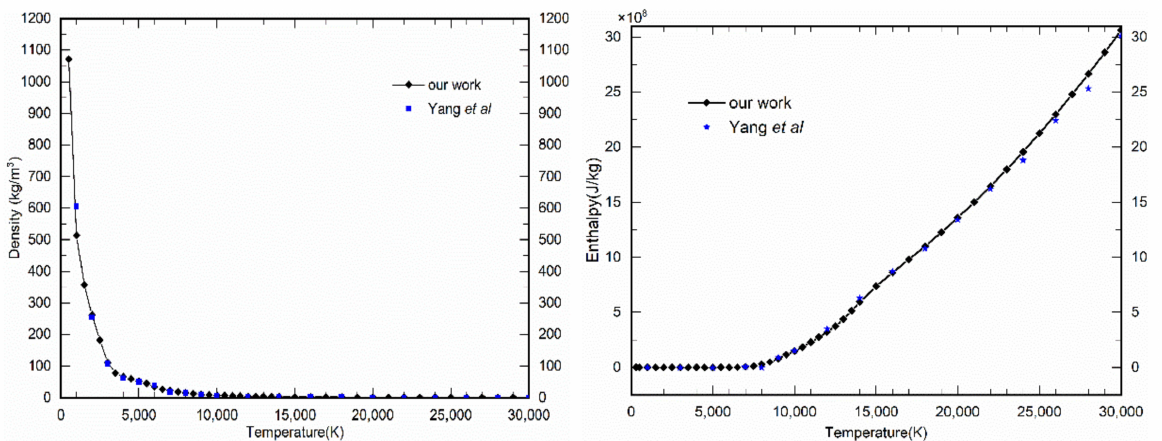
Figure 7. The density and enthalpy of pure CO 2 at 0.1MPa. The result is shown for comparison.